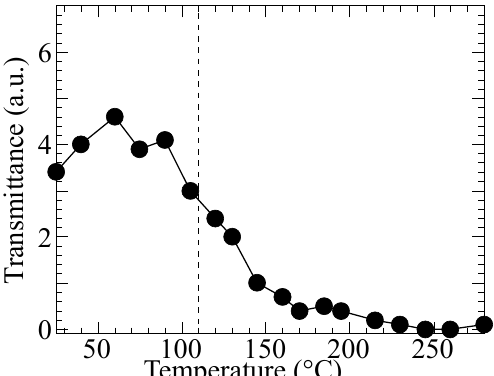
3 J/cm 2 and subsequent annealing at 180 ◦ C for 10 min. Hydrolysis is carried out by immersing acetic acid/water ( a ) 1/5 and ( b ) 1/3 solution at 50 ◦ C for 10 min and subsequent rinsing with methanol and diethyl ether. ( c ) Changes in the polarized FTIR spectra of an oriented P4 film before and after hydrolysis. Hydrolysis is carried out by immersing acetic acid/water 1/3 solution at 50 ◦ C for 10 min.